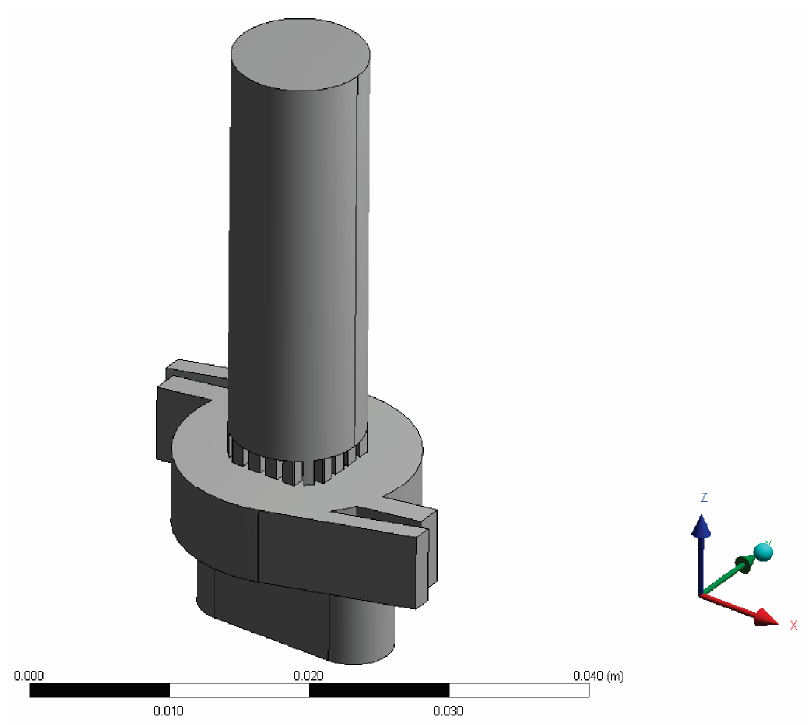
Figure 1. Device geometry; isometric view. Based on the created DPI geometry, an optimal finite volume mesh was generated using Ansys fluent meshing (Figure